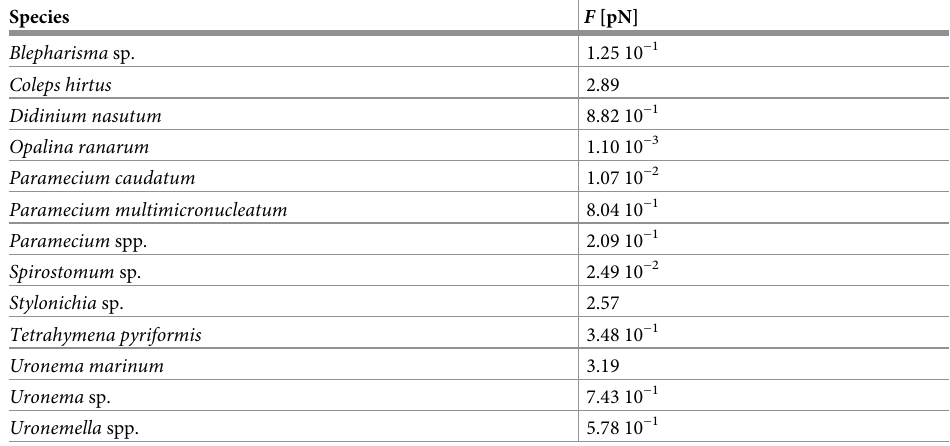
Table 2. Estimated values of the effective tangential force F exerted by each cilium for the species in Fig 22. Species F [pN] Blepharisma